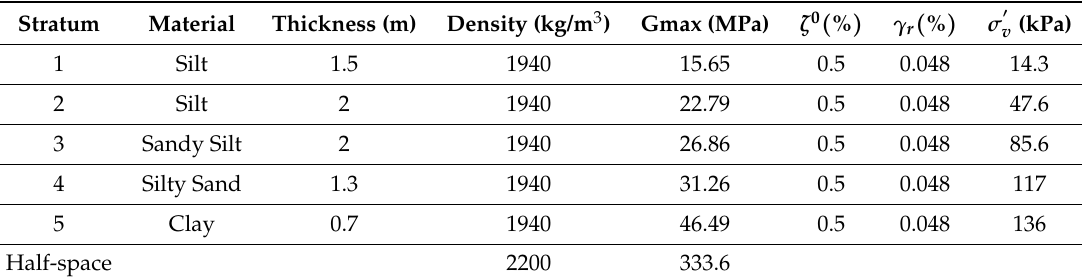
Table 1. Soil properties, with Gmax the initial shear modulus, ζ 0 ( % ) the damping ratio at small strains, γ r ( % ) the reference strain, and σ (cid:48) v the effective vertical